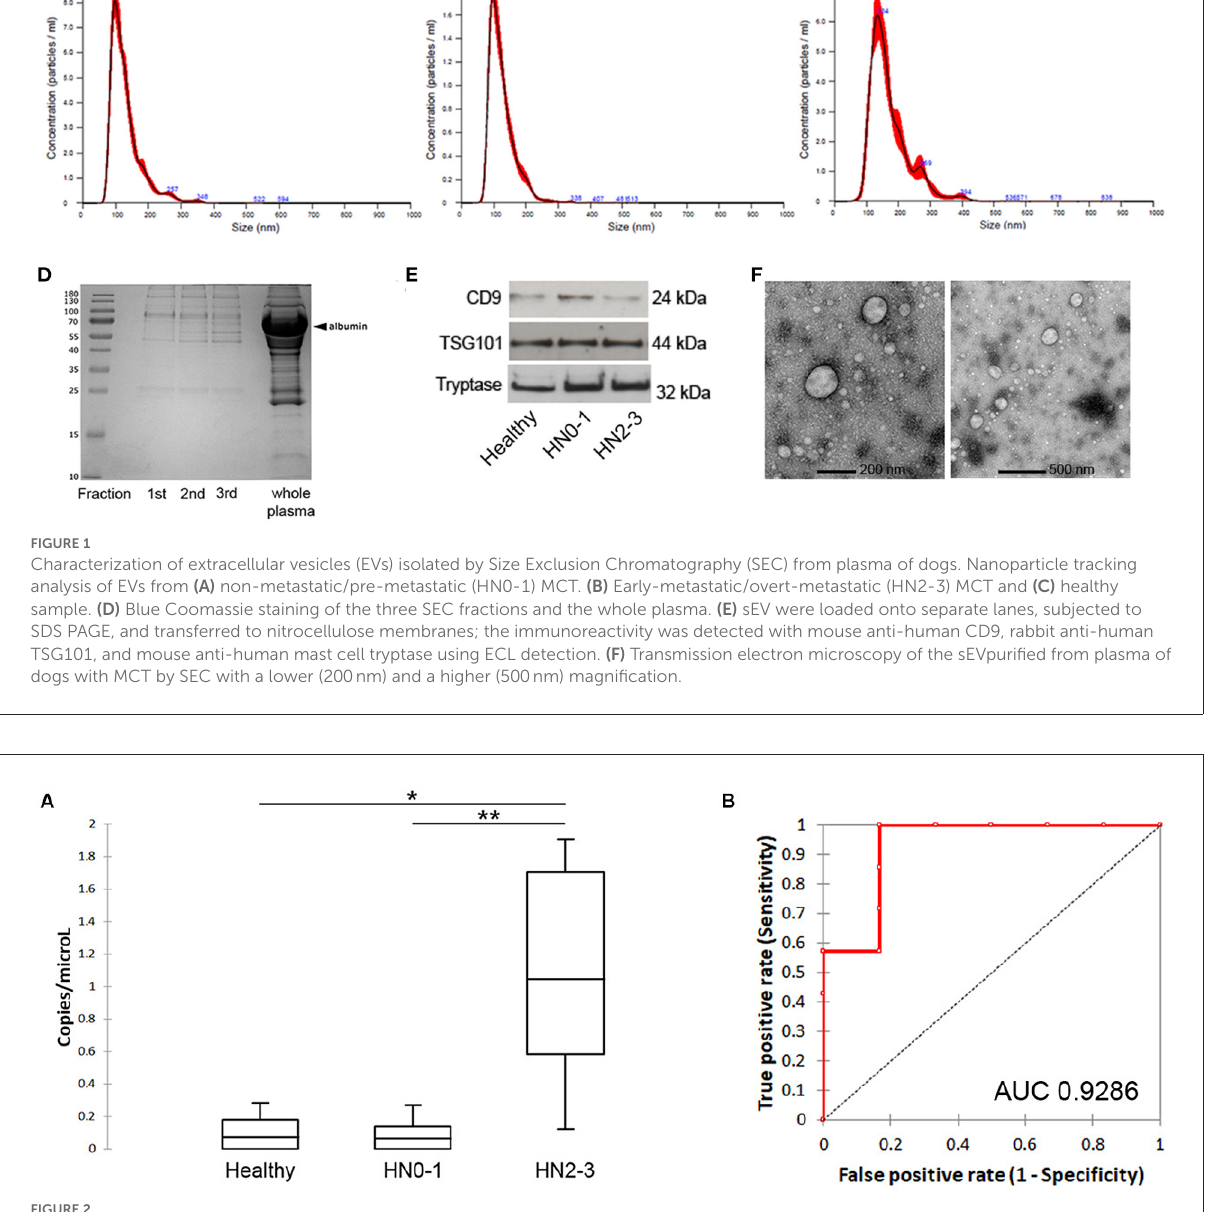
specificity are required to assess the same in veterinary medicine, especially for high-incidence cancer